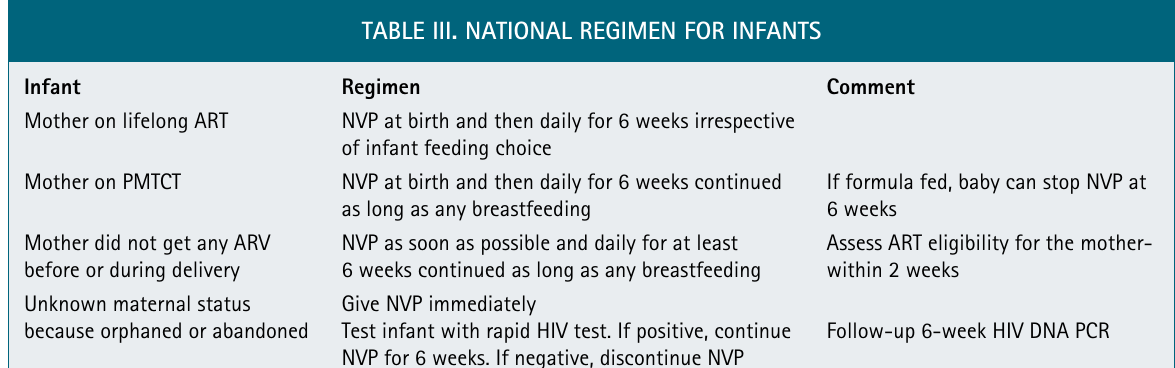
TABle iii. nATiOnAl RegiMen FOR inFAnTs